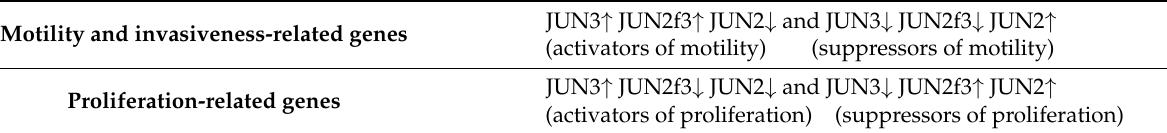
Table 2. Overall strategy of transcriptomic analysis. The distribution of transformation traits among JUN-2, JUN-2fos-3 and JUN-3 fibrosarcoma cell lines made us possible to identify separate sets of genes responsible for motility/invasiveness and proliferation, respectively, in a single transcriptomic analysis *. Motility and invasiveness-related